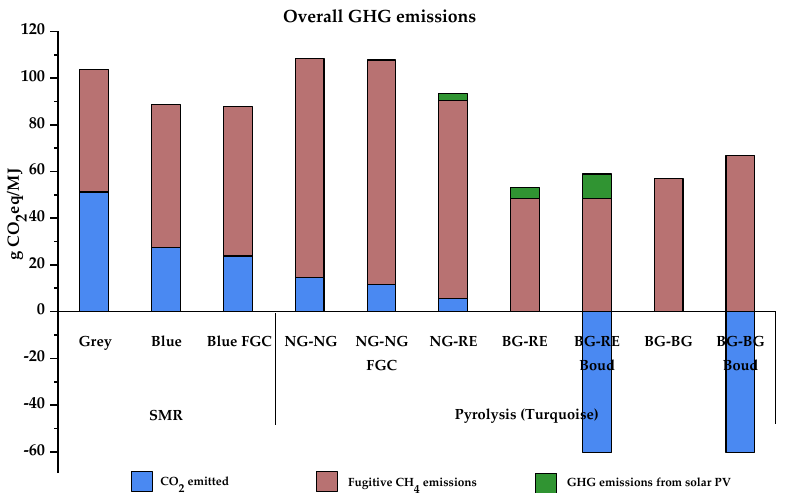
Figure 10. The overall GHG emissions for grey, blue, and turquoise hydrogen production.